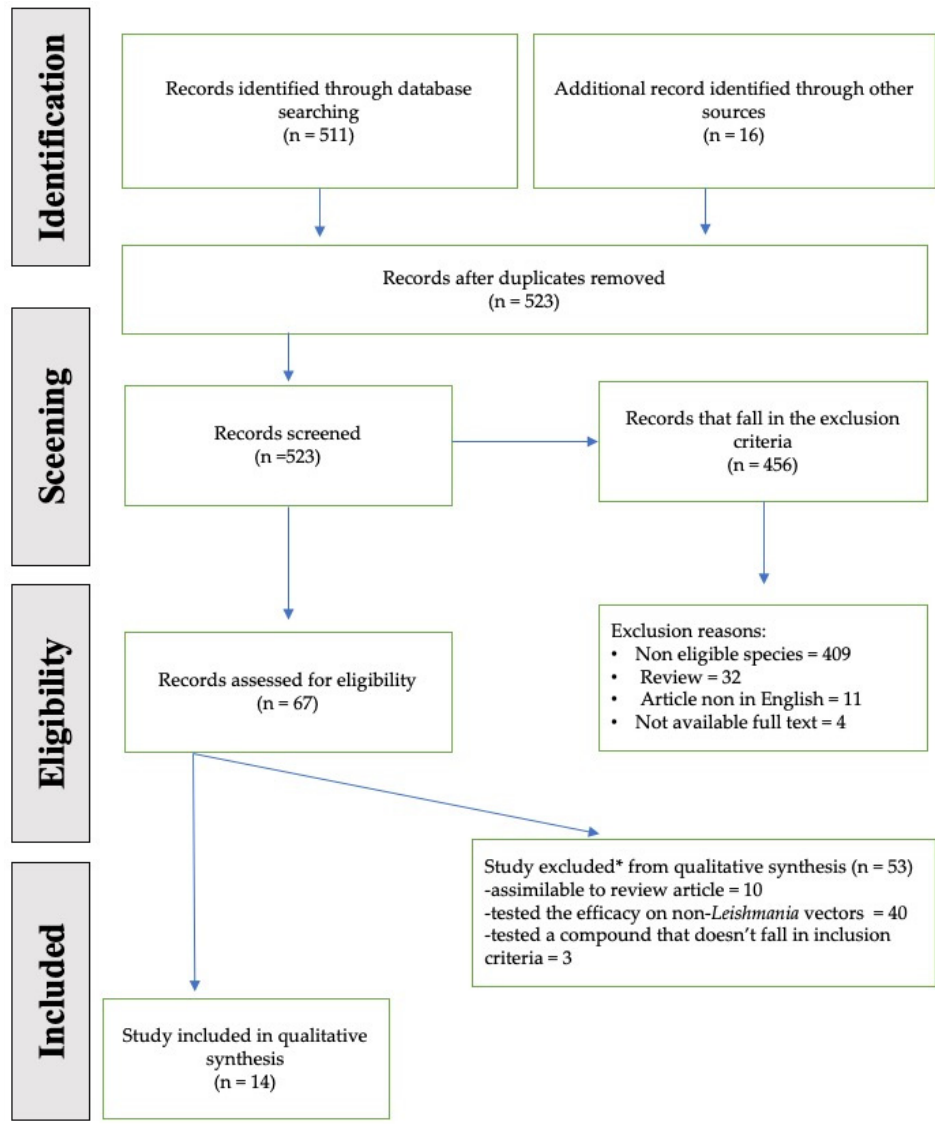
Figure 1. Scientific reports that fully satisfy the inclusion criteria.